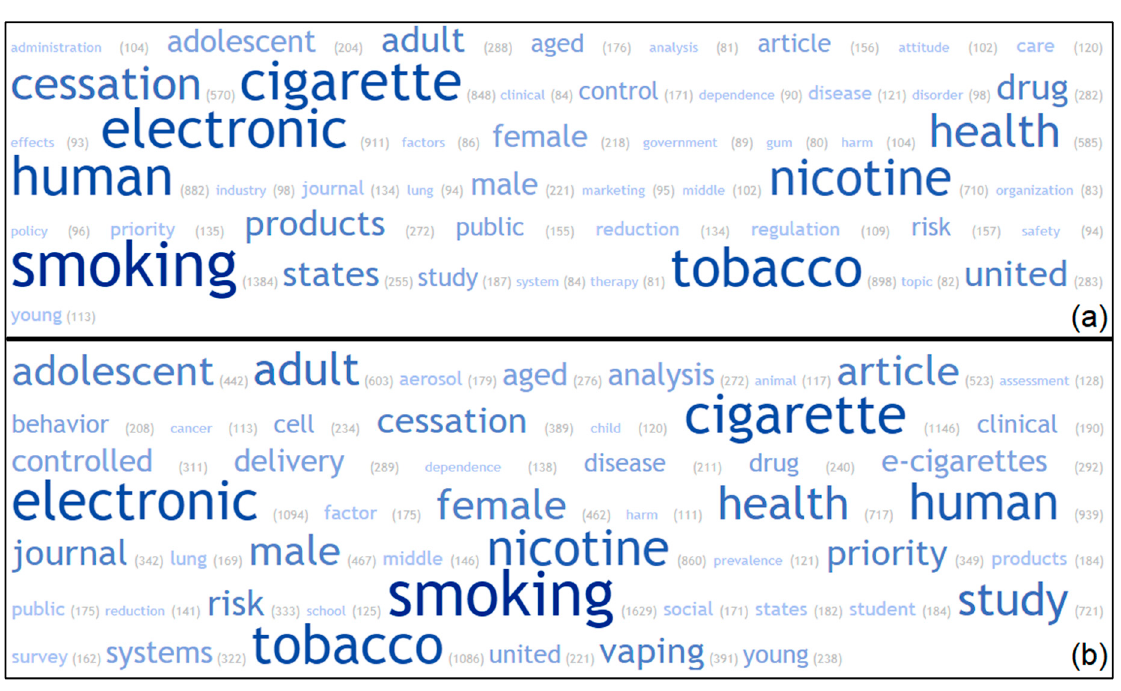
Figure 4. (a) Top 50 author-provided and indexed keywords in electronic cigarette publications in 2014. (b) Top 50 author-provided and indexed keywords in electronic cigarette publications in 2018. Bold text indicates the proportion of keyword mentions, and the number in parentheses shows the frequency of use.